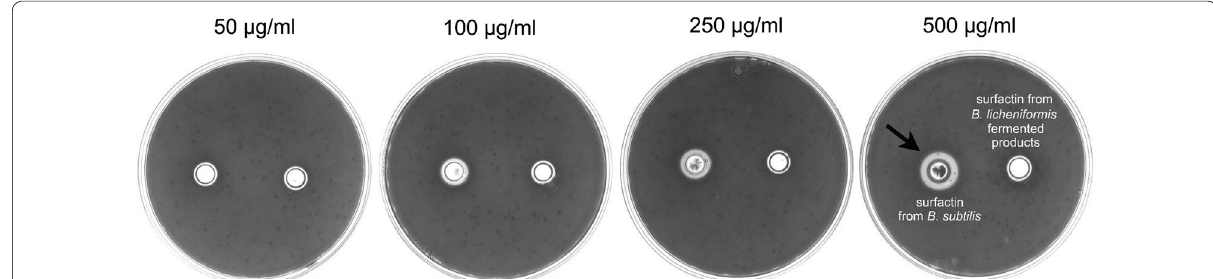
Fig. 3 Growth inhibitory zone of surfactin against B. hyodysenteriae using agar‑well diffusion assay. B. hyodysenteriae were grown in the different concentrations (50, 100, 250, 500 μg/ml) of surfactin produced from B. subtilis (left) and B. licheniformis ‑fermented products (right) for 24 h. The black arrow indicates inhibition zone. Three experiments were conducted, and one representative result is presented